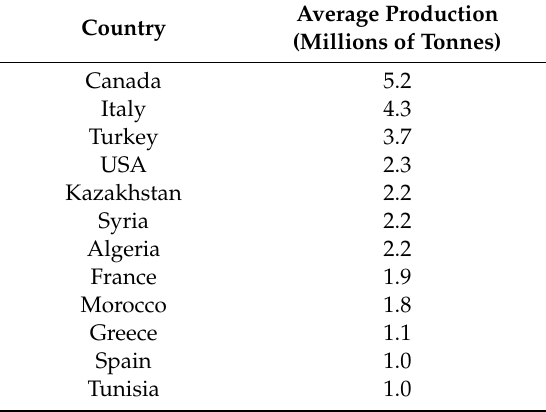
Table 1. The world’s leading durum wheat producing countries (2010–2019)